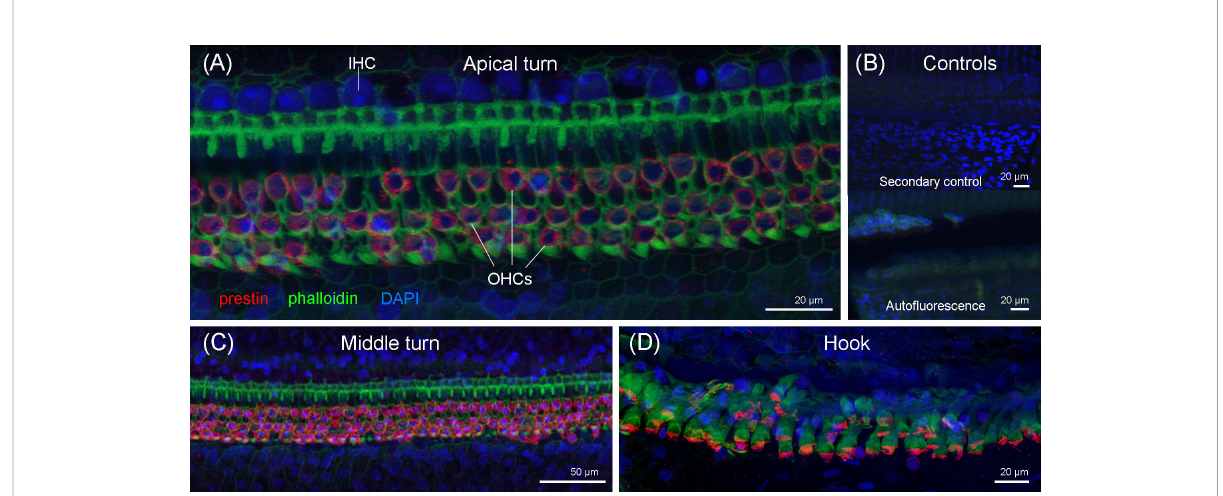
FIGURE 9 Maximum projections (up to 424 planes each 0.3 – 1 m m, depending on the magni fi cation) from the confocal microscope images of the apical turn (A) , middle turn (C) , and extreme basal turn or hook (D) of the right cochlea of the harbor porpoise. (B) Secondary (control for the non- speci fi c binding of the secondary antibodies) and auto fl uorescence controls were taken with the same settings as the apical region (Figure